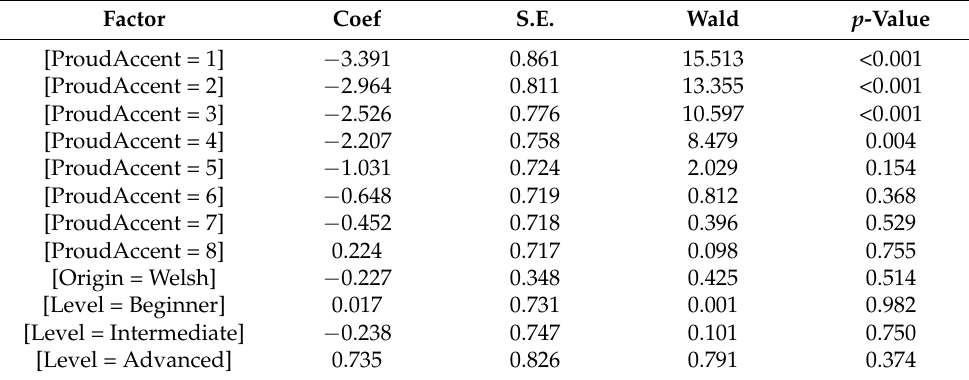
Table A7. Coefficients for I want to sound like a ‘native